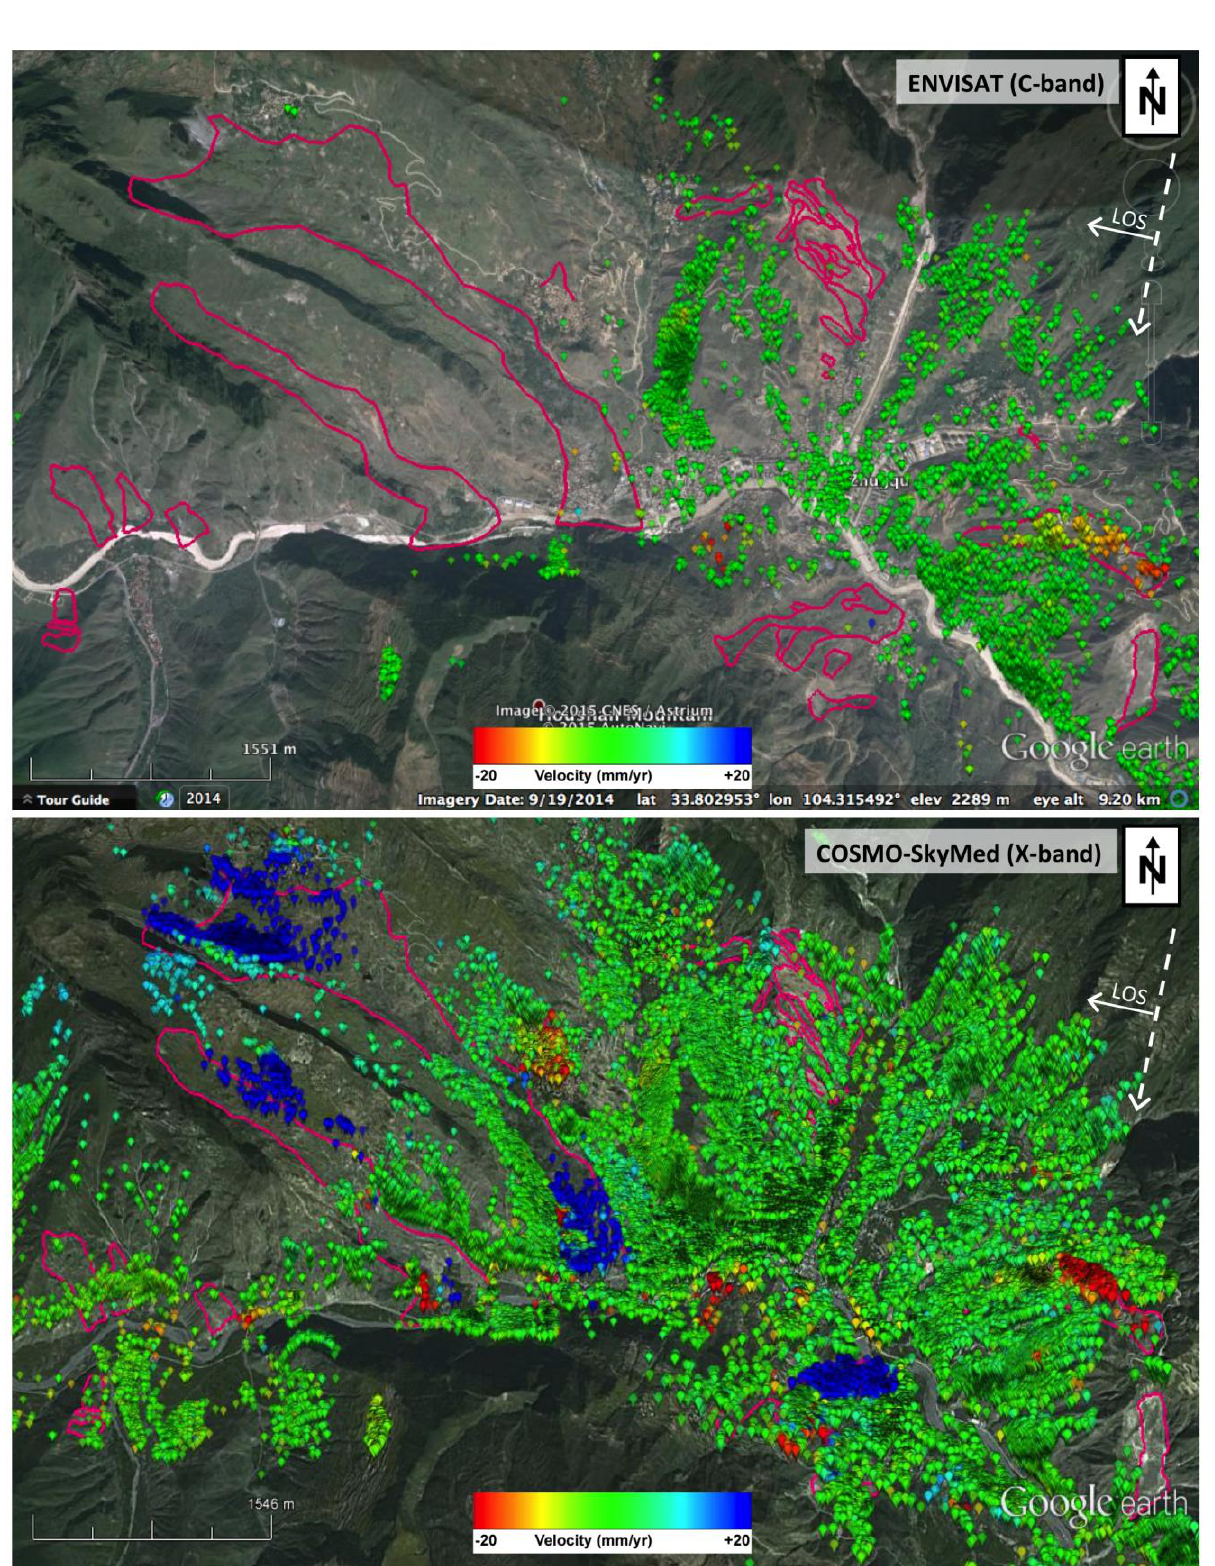
Figure 2. Local scale (~53 km 2 ) overviews of the distribution and average line of sight (LOS) velocity of radar targets in the Zhouqu area, Southern Gansu Mountains, China. Velocity values are saturated to ±20 mm/year. Yellowish-reddish and bluish dots represent radar targets moving, respectively, away from and toward the satellite sensor. The outlines of 25 landslides (in pink), mapped using Google Earth TM , are from Wasowski and Bovenga (2014b). Background images are from Google Earth TM . (Upper) MTI results obtained from ENVISAT data. (Lower) MTI results obtained from CSK data